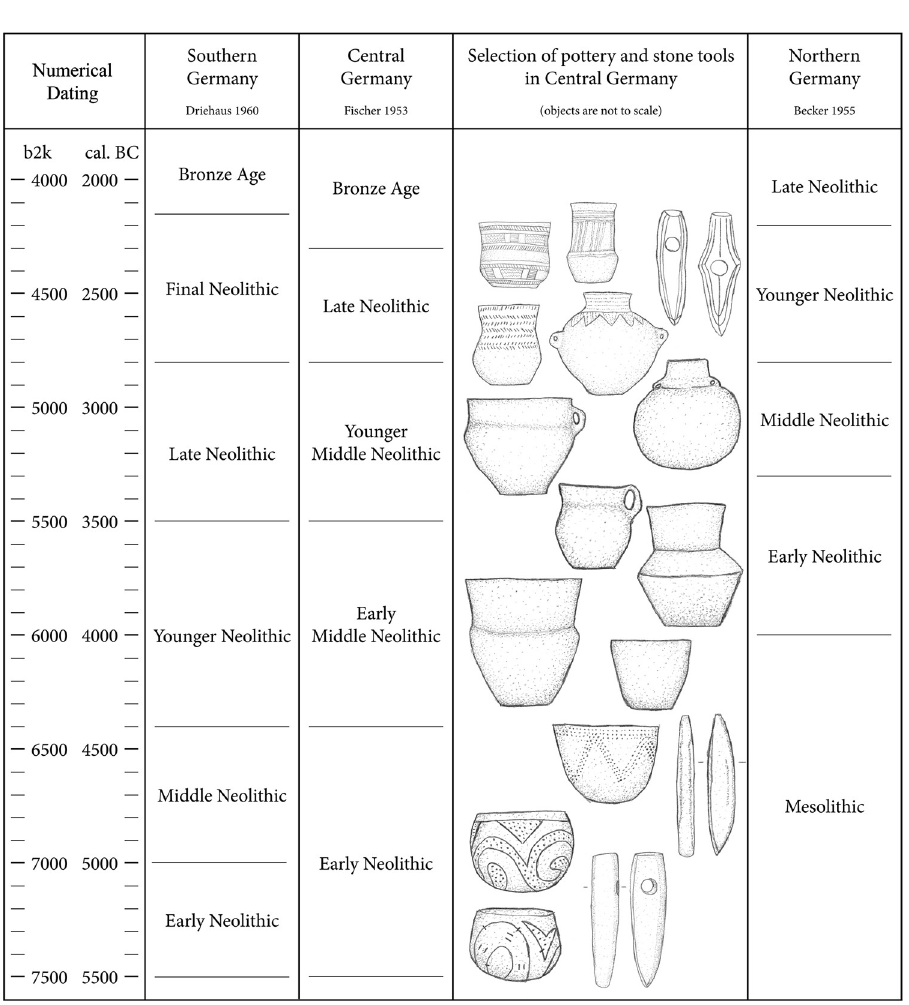
Fig 3. Terminology and chronology of Neolithic periods in Germany. For the Neolithic in Central Germany a selection of characteristic pottery and stone tools is added, drawings by Jan